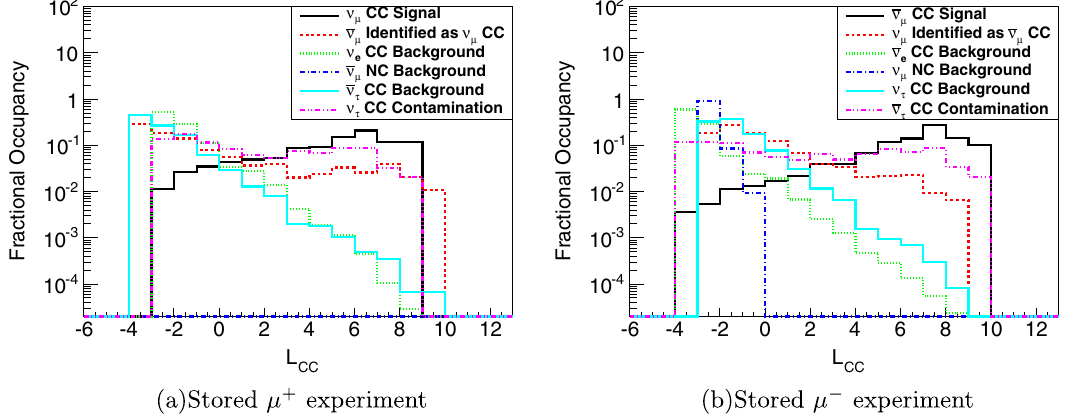
FIG. 6. Distribution of L CC for simulated neutrino species.